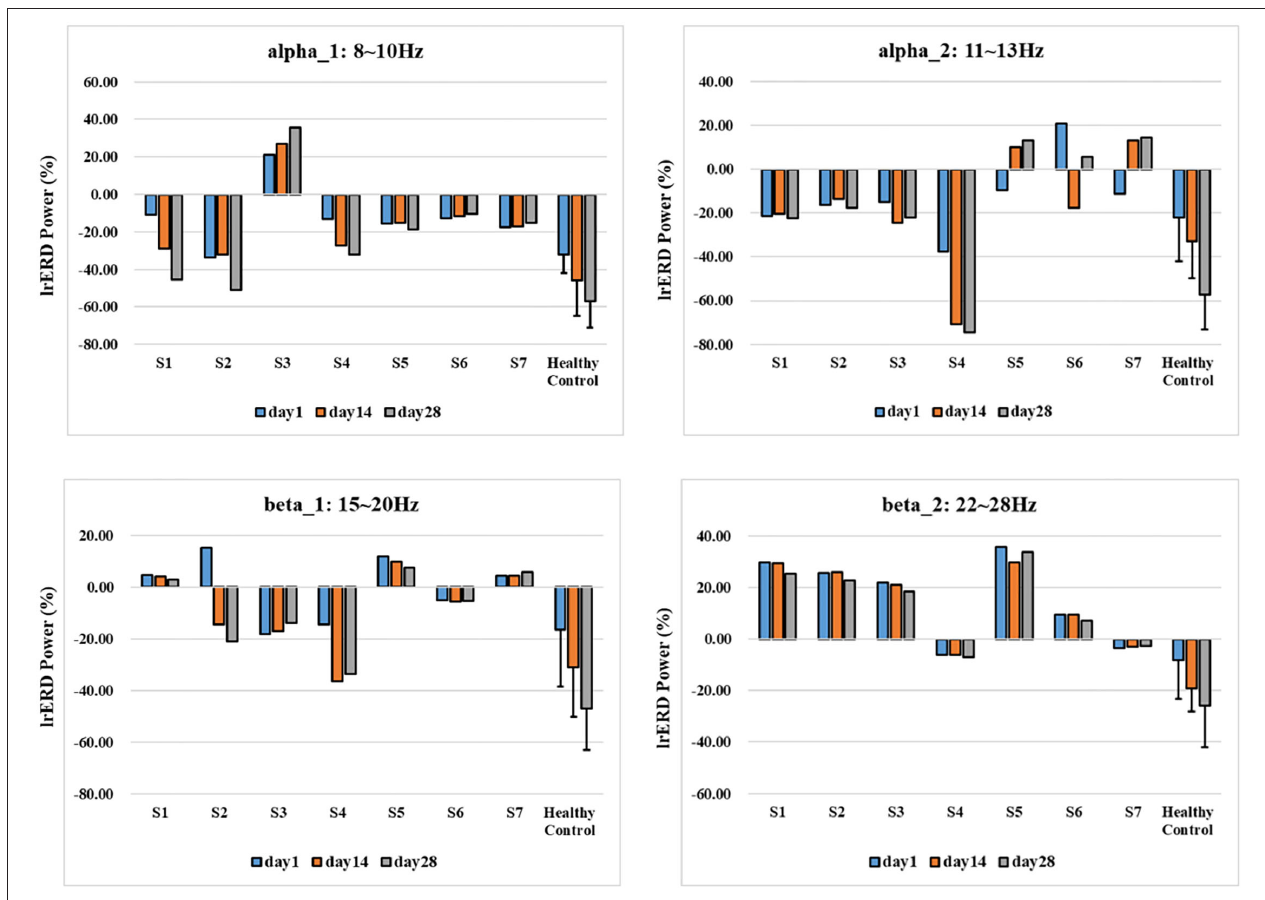
FIGURE 9 | lrERD characteristic pattern results of standard assessment session in long-term